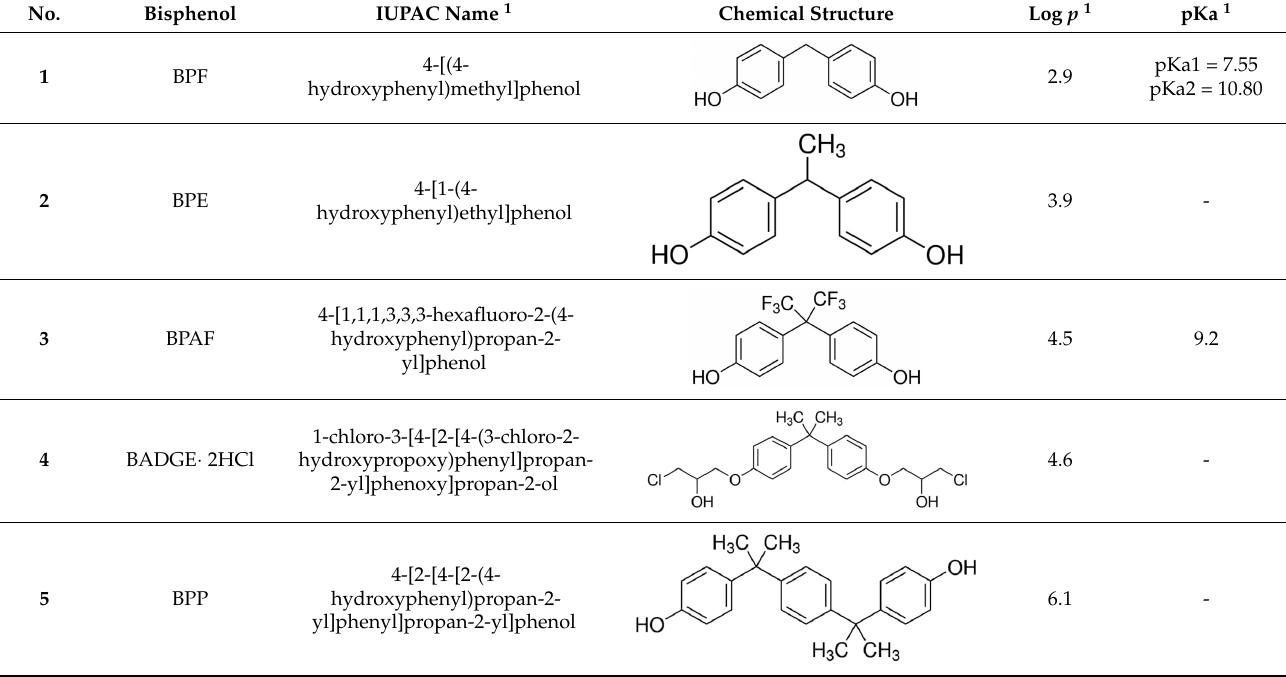
Table 1. Structures and physicochemical properties of studied bisphenols.